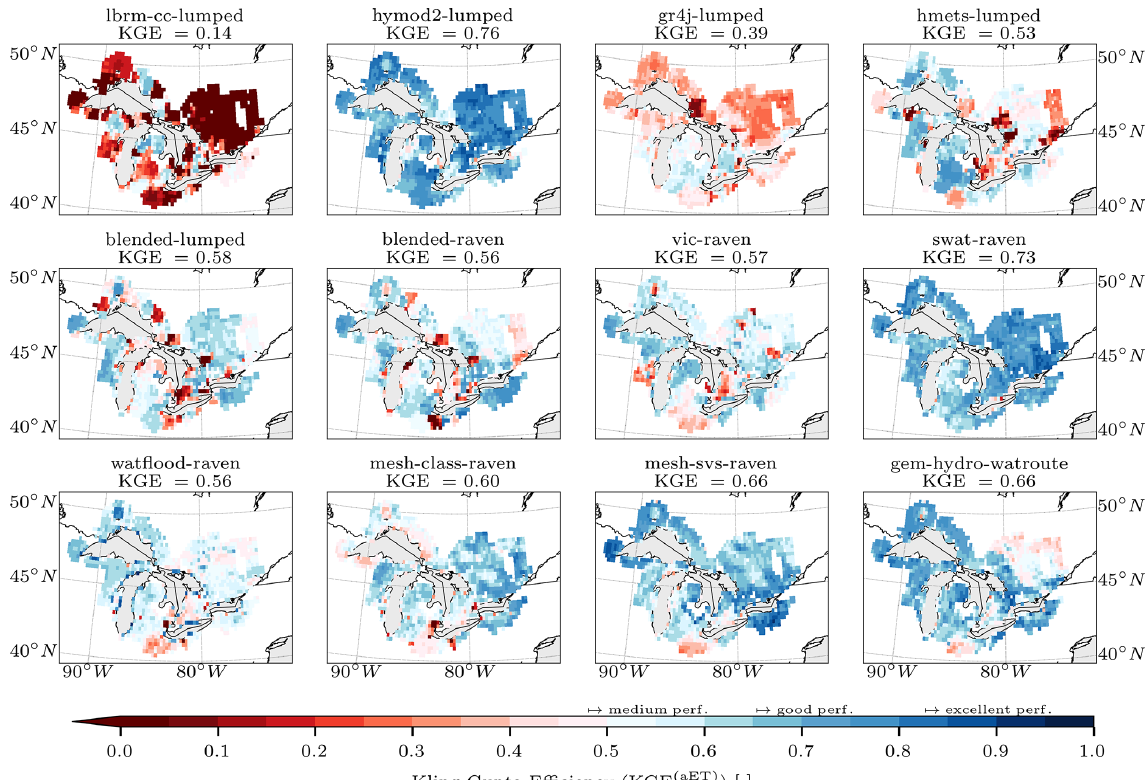
Figure 5. Grid-cell-based model performance regarding actual evapotranspiration. The performance of 12 models (panels) regarding actual evapotranspiration (AET) is shown. The model outputs are regridded to the grid of the reference dataset (here GLEAM v3.5b; variable E ). Only grid cells that are available in the reference dataset and all 12 models are displayed (1213 grid cells in total) and used to derive the Kling–Gupta efficiency (KGE) metrics based on all available observations between January 2001 and December 2017. The median KGE across space is added as a label at the top of each panel. The color bar has labels added to categorize the performance into medium, good, and excellent. The machine-learning-based LSTM model is not displayed, as this is the only model not simulating actual evapotranspiration